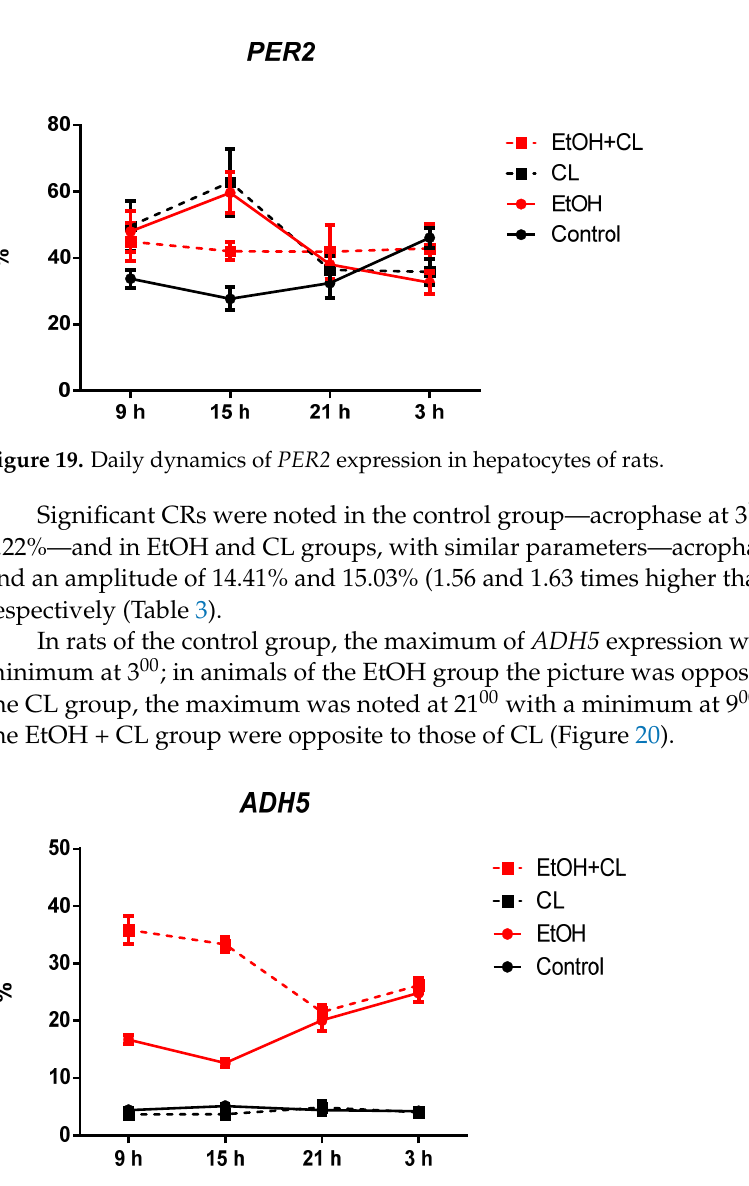
Figure 20. Diurnal dynamics of ADH5 expression in hepatocytes of rats.